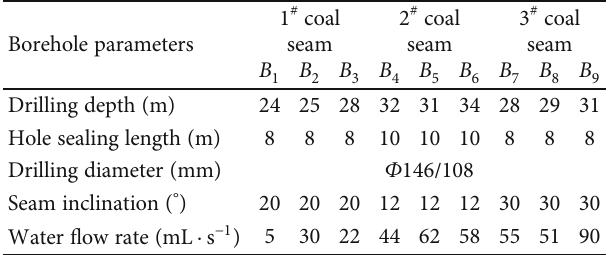
Table 3: Drilling parameters for pressure boreholes in coal seams. 1 # Borehole parameters